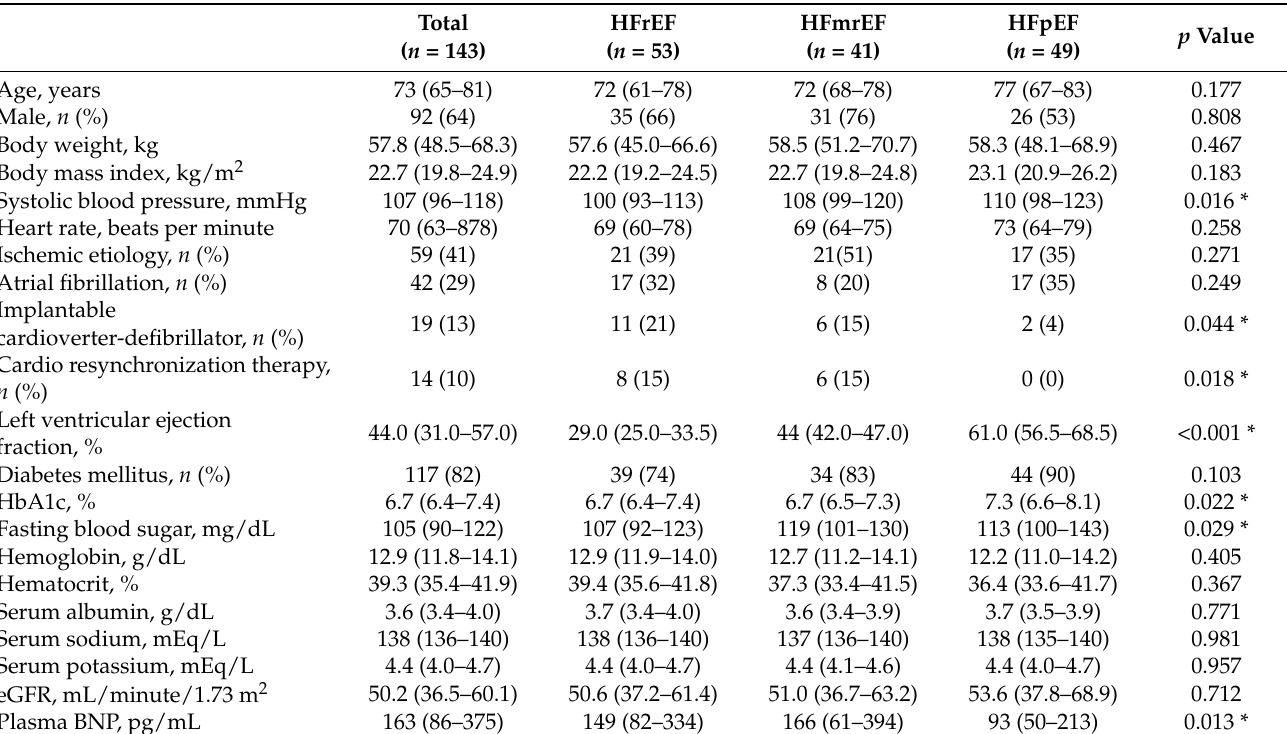
Table A2. Baseline characteristics of the HFrEF/HFmrEF/HFpEF